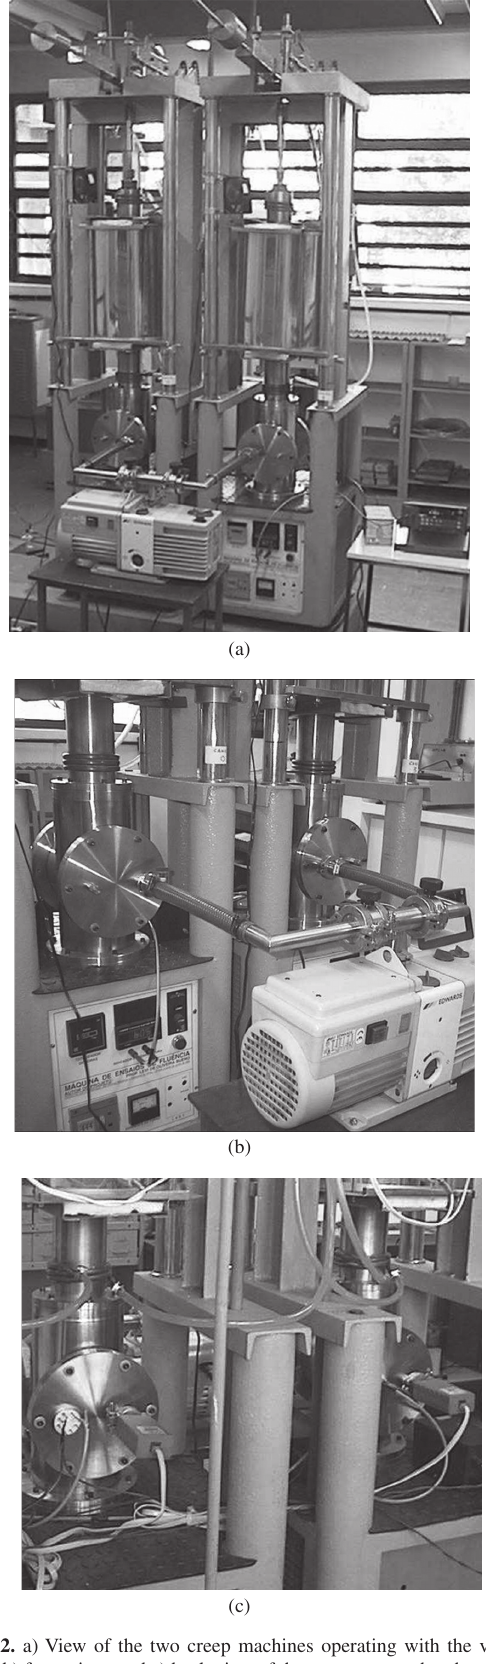
comparison between creep curves obtained in air and in vacuum for the different temperature and stress levels applied in the tests.